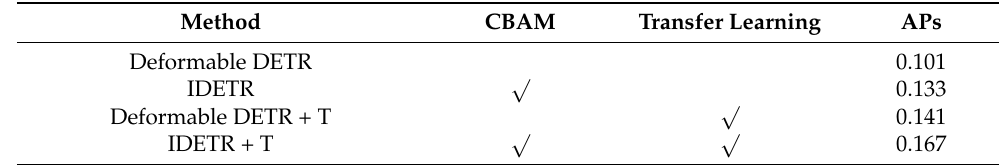
Table 4. Results of ablation